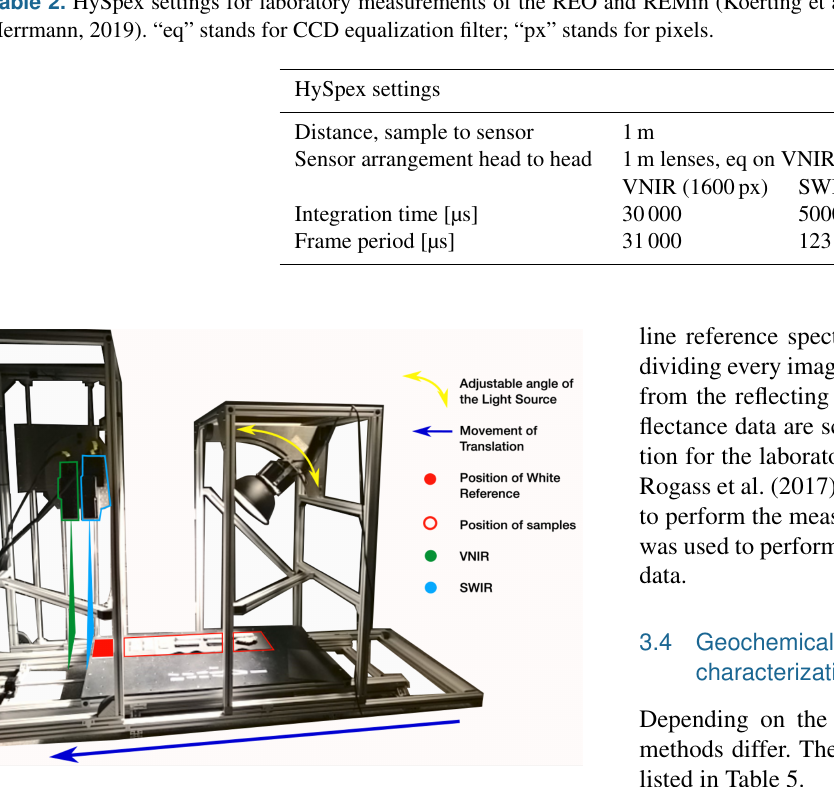
Figure 6. The HySpex translation stage setup (Körting,